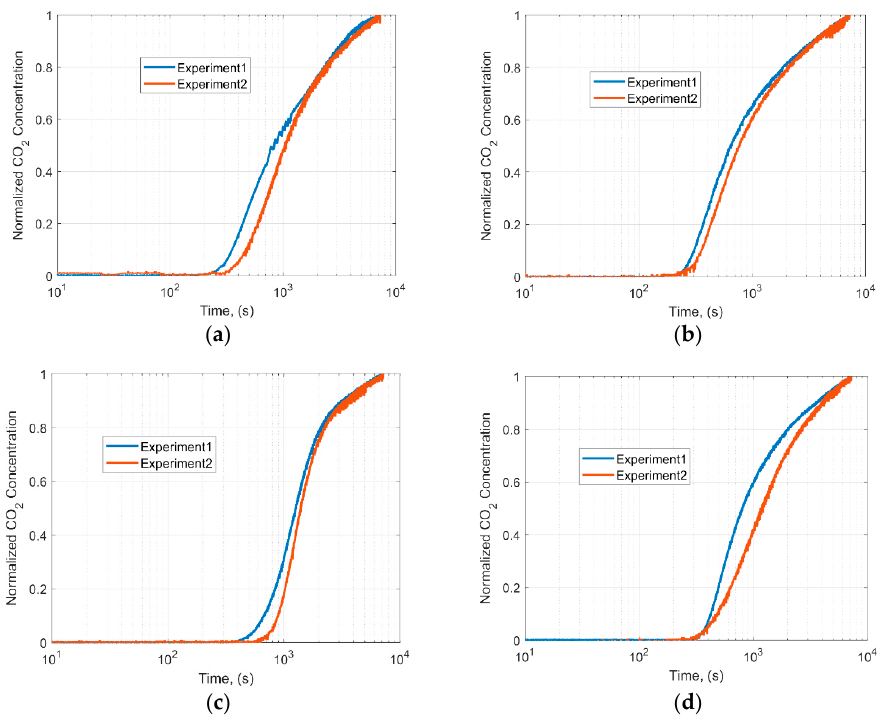
Figure 7. Response of the fluidized bed with particle mixing in different proportions of external group B particles ( a ) X 1 = 0.00; ( b ) X 1 = 0.05; ( c ) X 1 = 0.10; ( d ) X 1 =